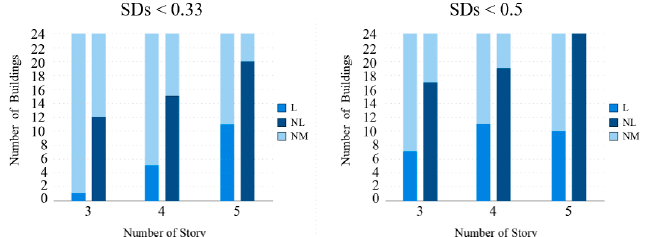
Figure 11. Distribution of buildings with sufficient performance according to the storey number/S DS .